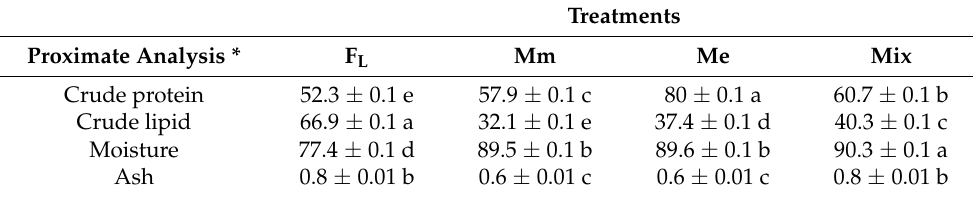
Table 2. The proximate composition of prey: Forage larvae of Piaractus brachypomus (F L ); Moina minuta (Mm); Macrothrix elegans (Me); mixture (50:50) of the Moina minuta and Macrothrix elegans (Mix). Different letters in the same row indicate a significant difference ( p < 0.05). * Dry